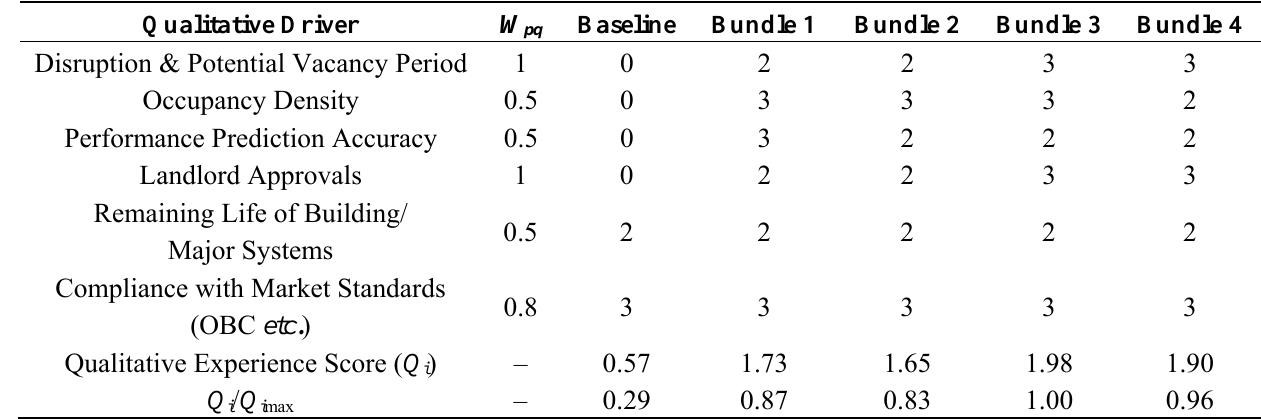
Table 6. Qualitative factor evaluation.